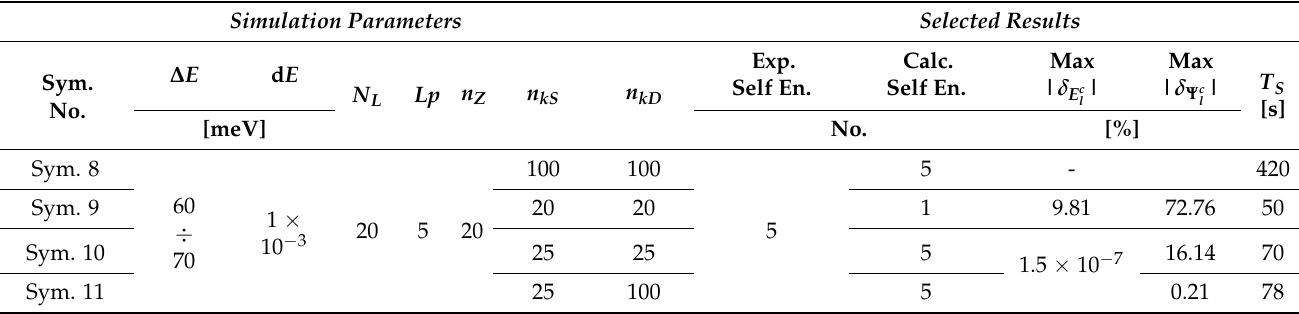
Table 5. Basic parameters and selected results of simulations for structure presented in [28].